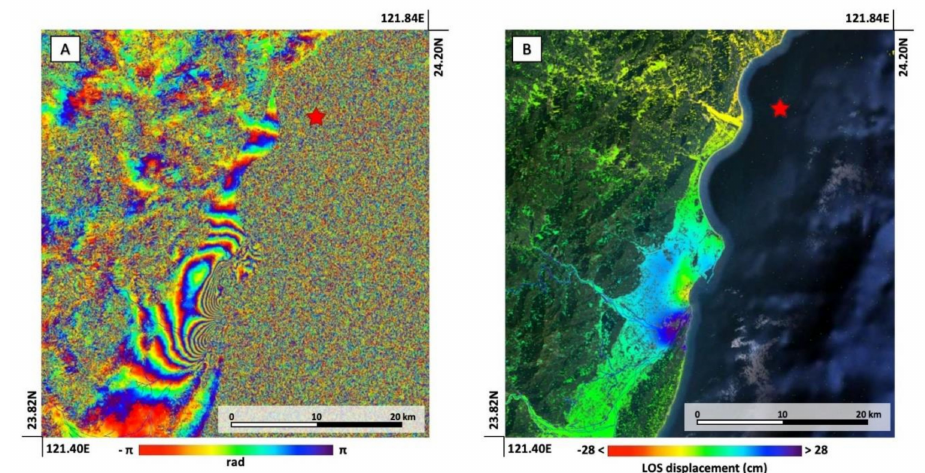
Figure 11. Sentinel-1 results relevant to the 4 February 2018 Hualien (Taiwan) earthquake. ( A ) Coseismic interferogram produced from S1 ascending images (Track 69) spanning the time interval 3 February 2018–9 February 2018. ( B ) Coseismic displacement map related to the interferogram reported in ( A ). The red star identifies the earthquake